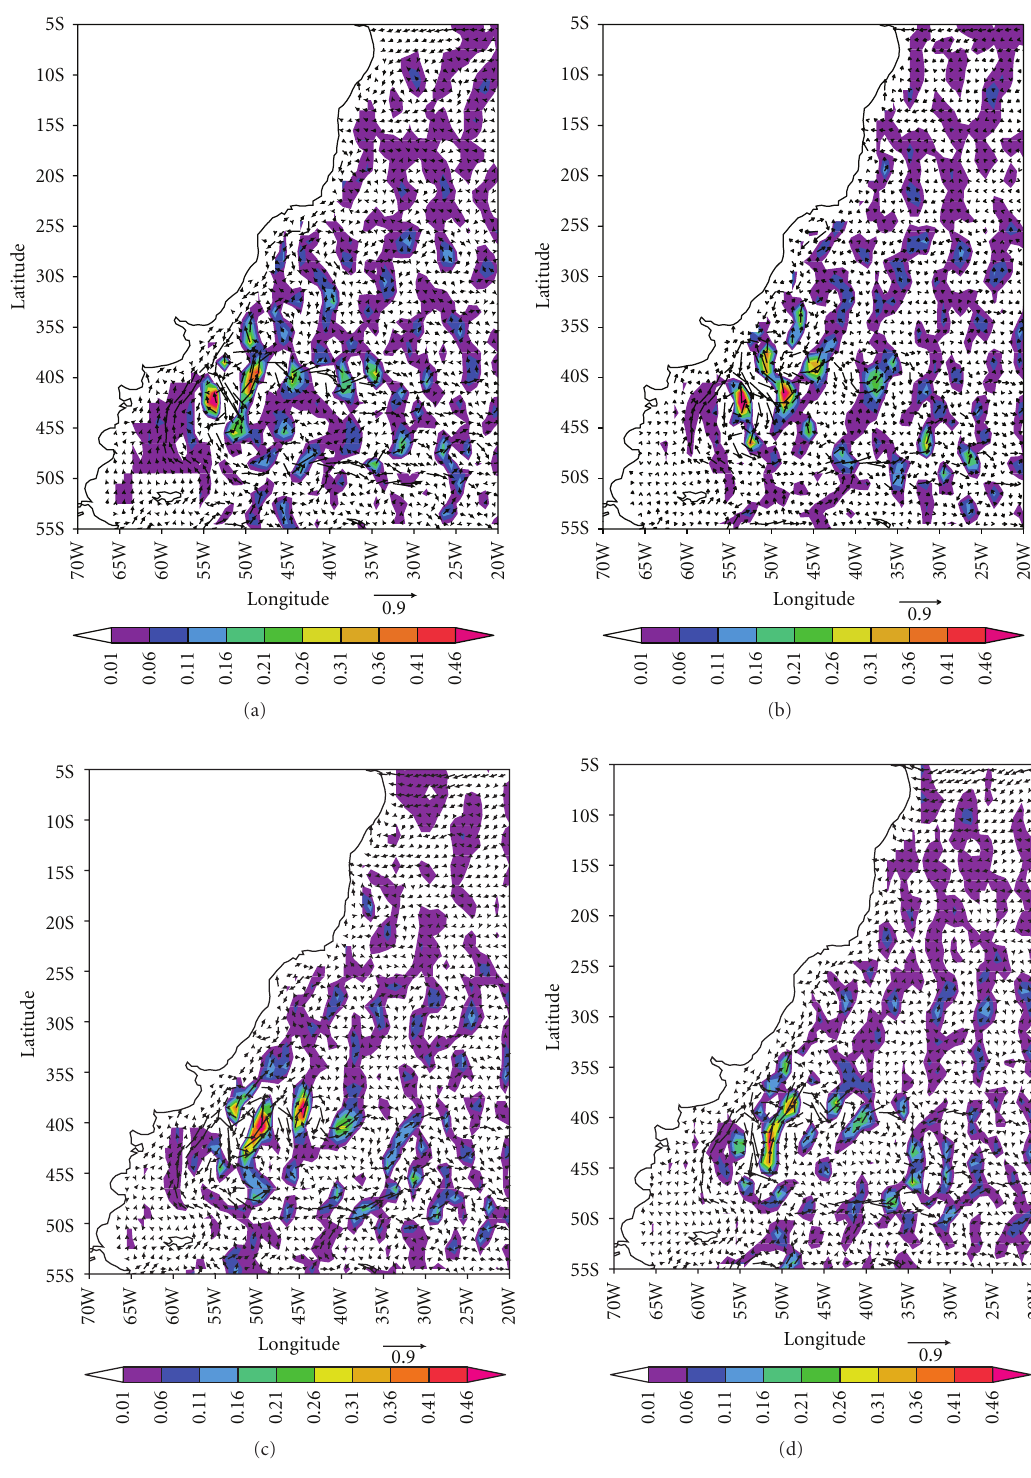
Figure 4: Ocean currents and positive meridional velocity anomaly (ms − 1 ) relative to the mean from 1993 to 2009 from the program OSCAR, for (a) April, (b) May, (c) June, and (d) July (source: